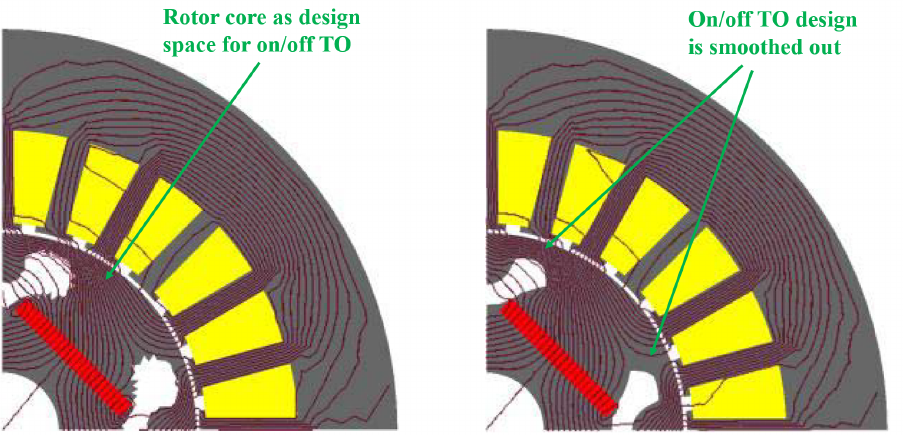
Figure 10. Example of a rotor core of a permanent magnet machine achieved via on/off TO algorithm. The TO design is smoothed out. Figure is adapted from